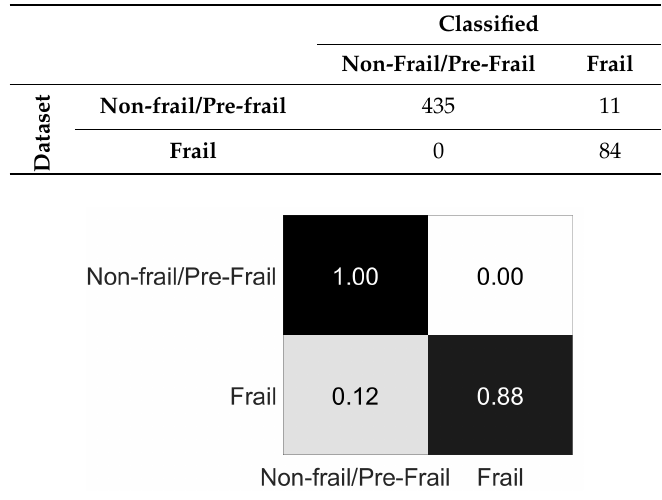
Figure 11. Percentage confusion matrix for Table